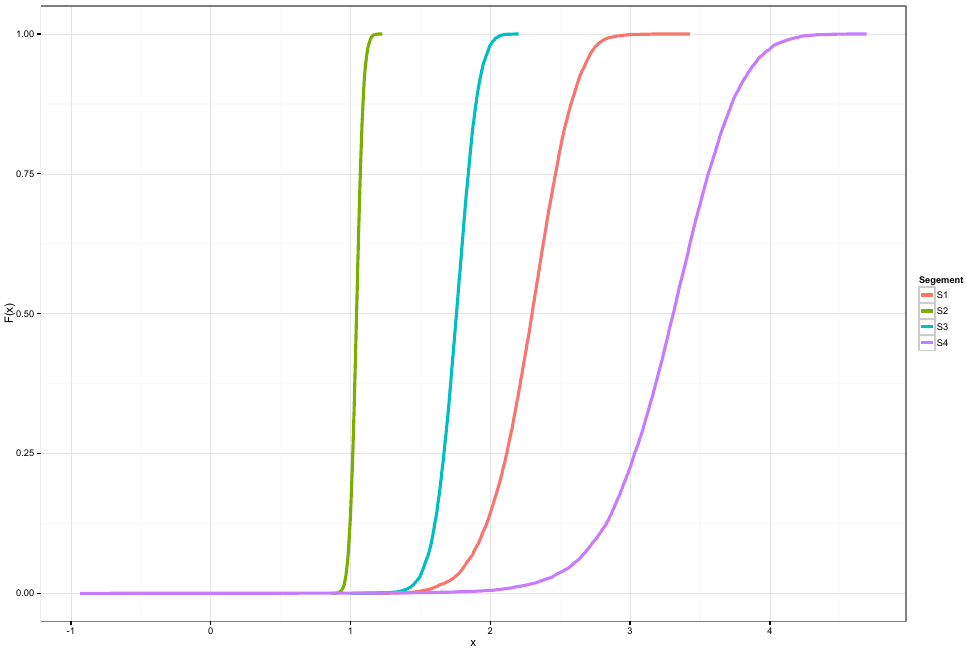
Figure 2. The graph depicts distribution functions that follow a stochastic dominance ordering. The distribution functions may be interpreted as those functions that describe the risk of particular portfolios or